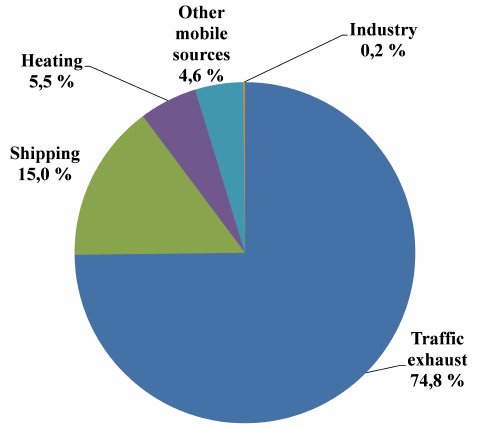
Figure 5. The contributions of various source categories on the total emissions of particulate number in Oslo in 2008. The total amount of emissions was 1.1 × 10 24 particlesyear − 1